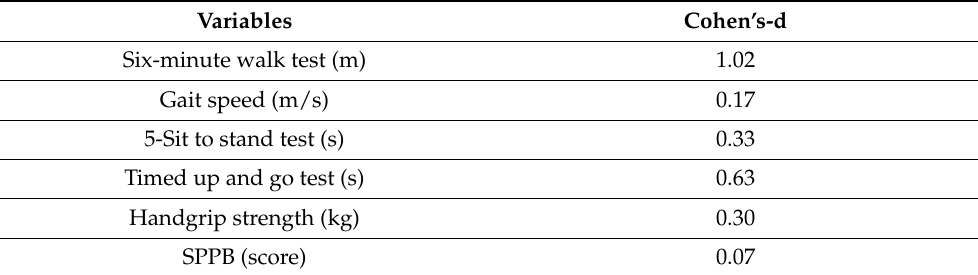
Figure 2. Intragroup and intergroup changes in physical function tests. p *: ANOVA (3 times × 2 groups). Table 3. Effect size (Cohen’s-d) calculation for physical function tests.